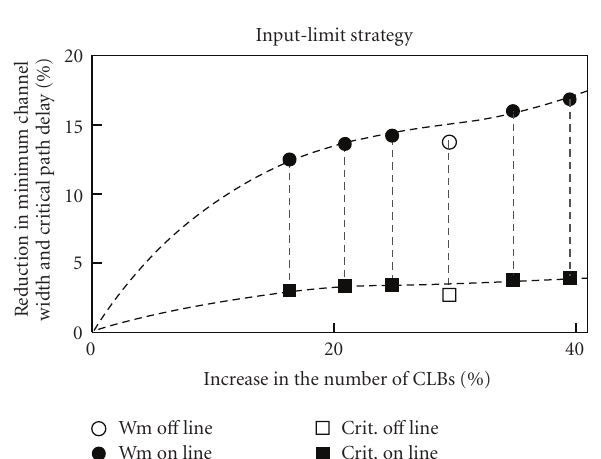
Figure 7: Minimum channel width (Wm) and critical path delay (crit) reduction of T-NDPack with “ input-limit ” strategy relative to T-VPack. Circles represent channel width savings of T-NDPack relative to T-VPack. Squares represent critical path delay savings. Dashed line represents best line drawn over the data points. Points that are on the line are filled (Wm on line and crit. on line). Dotted line represents circle and square data points collected based on the same experimental configuration.